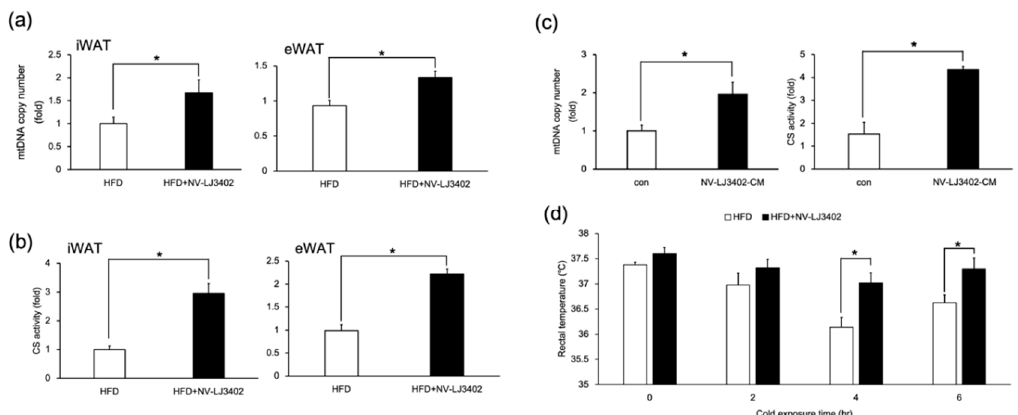
Figure 4. NV-LJ3402 enhances mitochondrial levels and increases the body temperature in HFD-fed mice. ( a , b ) Mitochondrial DNA (mtDNA) copy number ( a ) and citrate synthase activity ( b ) in inguinal WAT (iWAT) and eWAT of HFD and HFD-NV-LJ3402 mice ( n = 5–7 per group). ( c ) Day 6 3T3-L1 adipocytes were treated with NV-LJ3402-CM for 48 h, and then mtDNA copy number and citrate synthase activity were measured on day 8, as indicated. mtDNA levels were normalized to those of nuclear genomic DNA. The results are from three independent experiments. ( d ) Core body temperature was measured based on rectal temperatures at 25 °C (0 h) and 4 °C for different durations (2 ‒ 6 h) ( n = 7 per group). All data are expressed as the mean ± S.E.M. HFD vs. HFD+NV-LJ3402, con vs. NV-LJ3402-CM, * p < 0.05.